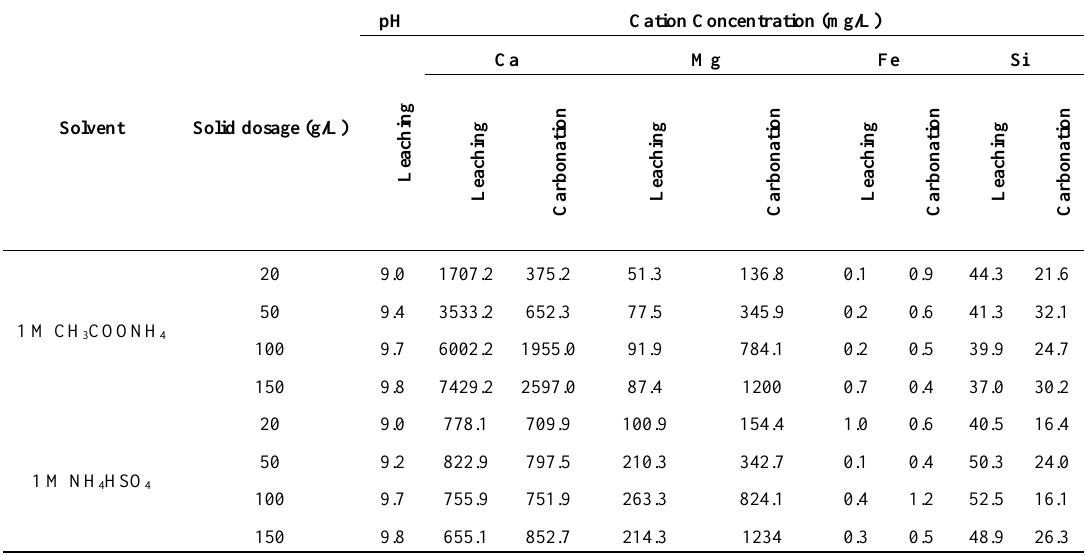
Table 2. Results of chemical analysis for filtrates obtained from leaching and carbonation tests.